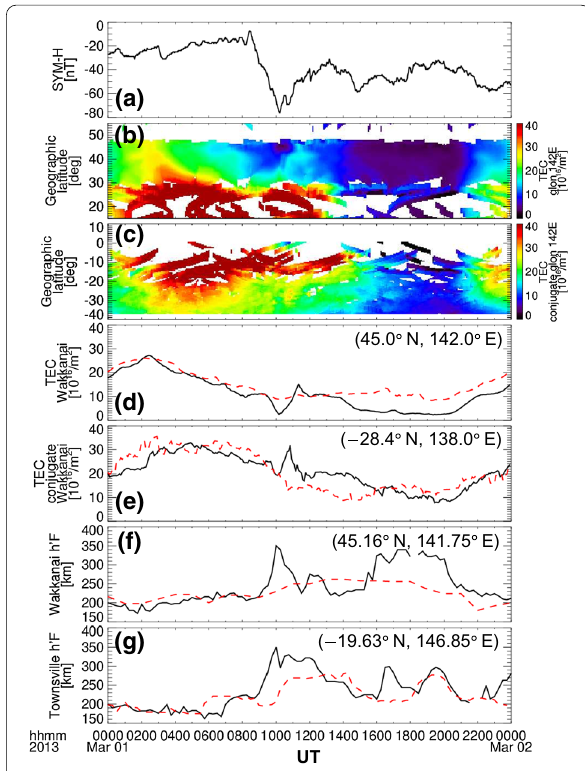
Fig. 8 Time-series plot of a SYM-H index, and geographic latitude– time plots of vertical TEC, b from 15° to 55° N at 142° E and c over geomagnetically conjugate points in the southern hemisphere for the location of 15°–55° N at 142° E on March 1, 2013. Panels d and e show temporal variations of vertical TEC near Wakkanai (45.0° N, 142.0° E) and the geomagnetically conjugate point to Wakkanai ( 28.4° N, 138.0° E) on March 1, respectively. The dashed red curves − in Panels f and g indicate the vertical TEC values on March 8, which was the geomagnetically quietest day in March 2013. Panels f and g show ionospheric virtual heights (h’F) at Wakkanai and Townsville on March 1, respectively. The dashed red curves in Panels f and g indicate the quiet-time values of ionospheric virtual heights on March 8. Universal time plus 9 h corresponds to the local time in the Asian sector